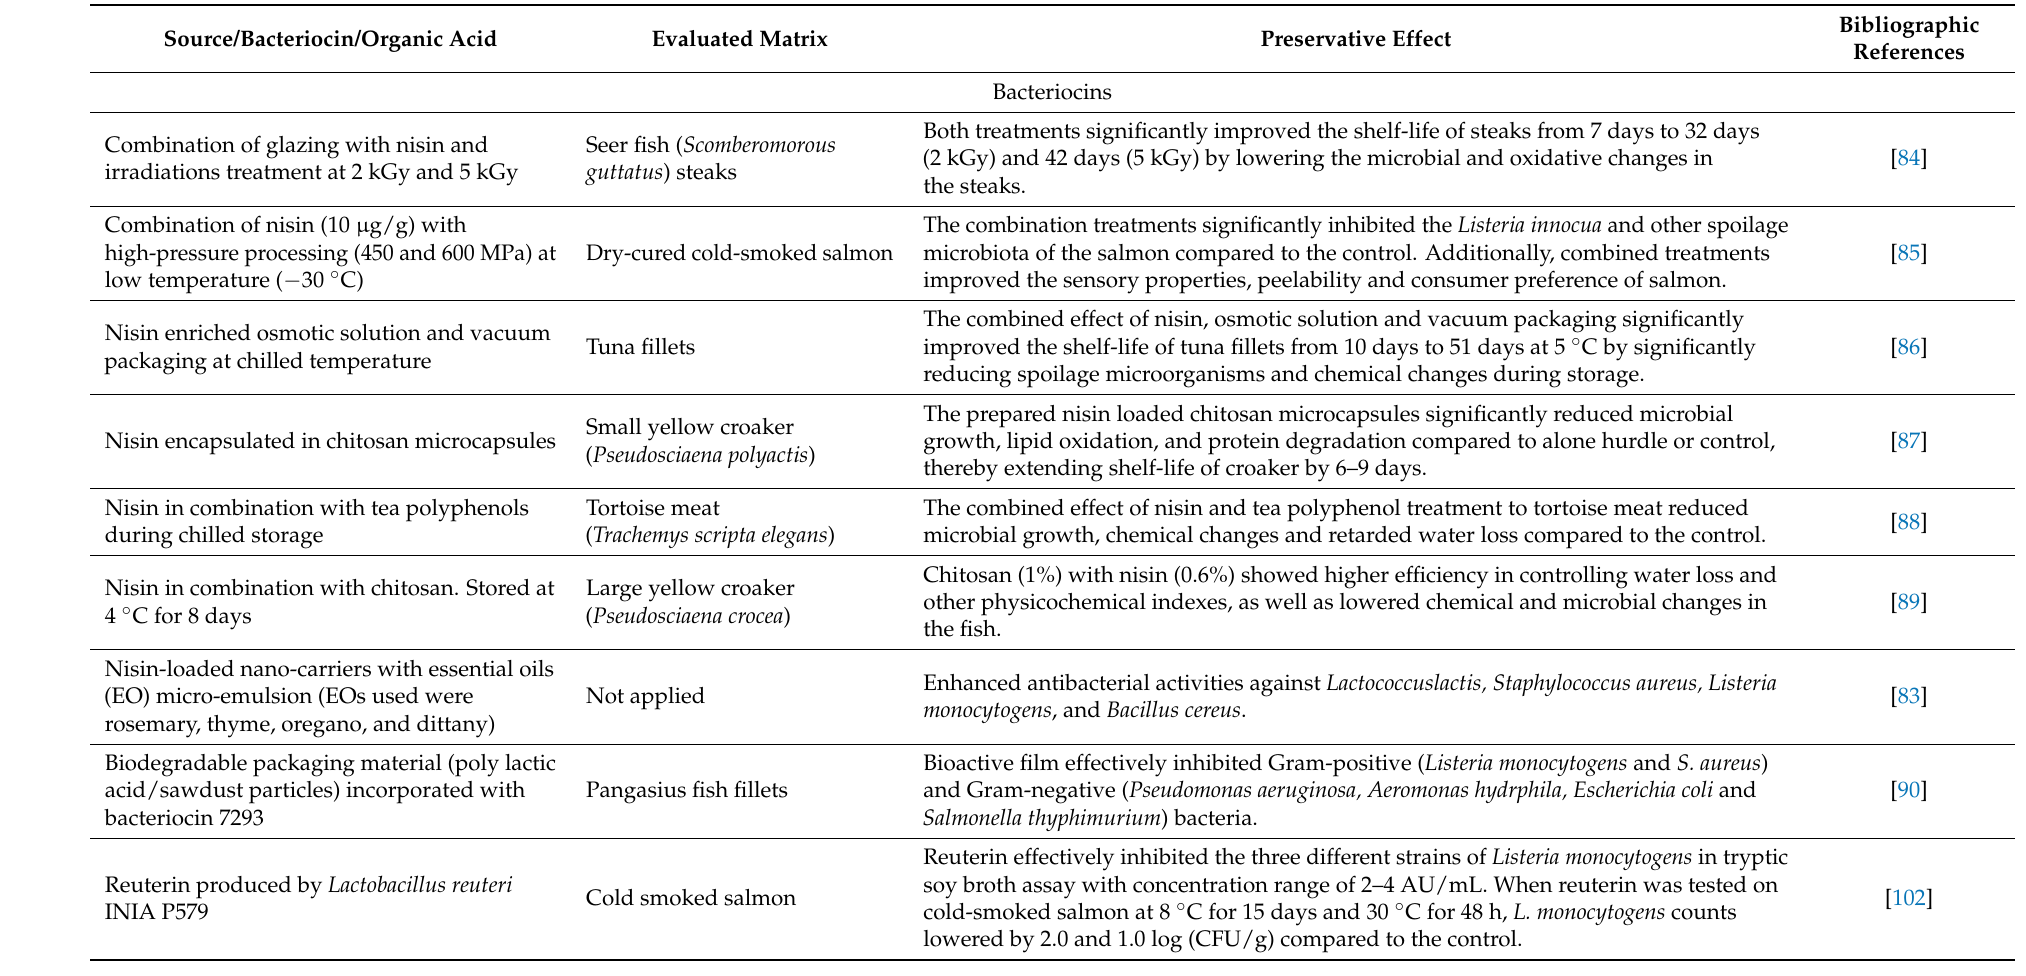
Table 1. Preservative effects of the microbial metabolites bacteriocins and organic